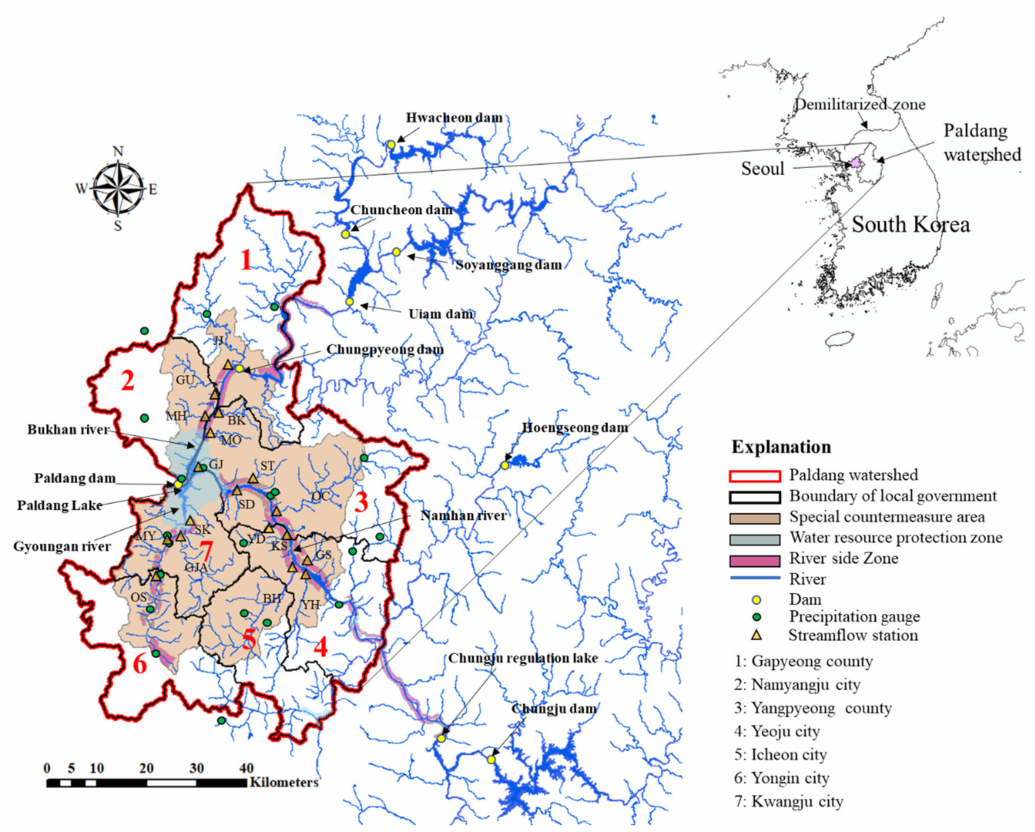
Figure 1. The regions of the Paldang watershed based on the administrative district. JJ, GU, MH, BK, and MO are tributaries of the Bukhan River, GJ, ST, OC, GS, SD, YD, KS, BH, and YH are tributaries